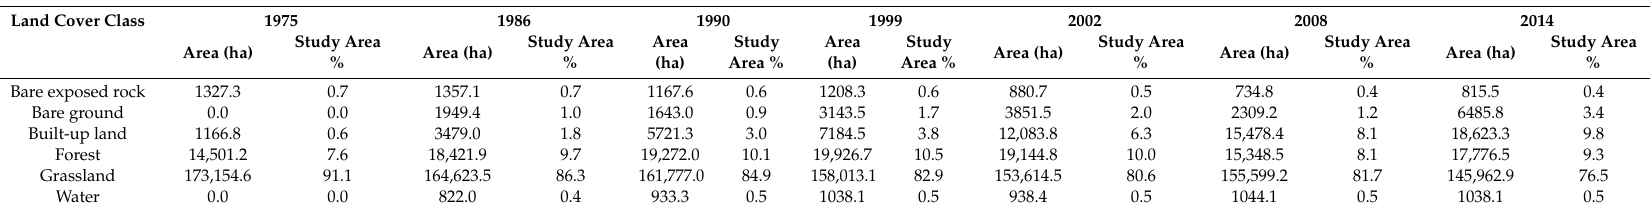
Table 3. Areal coverage of each land cover class (in both ha and percentage of study area) for the 1975, 1986, 1990, 1999, 2002, 2008 and 2014 land cover classifications. Land Cover